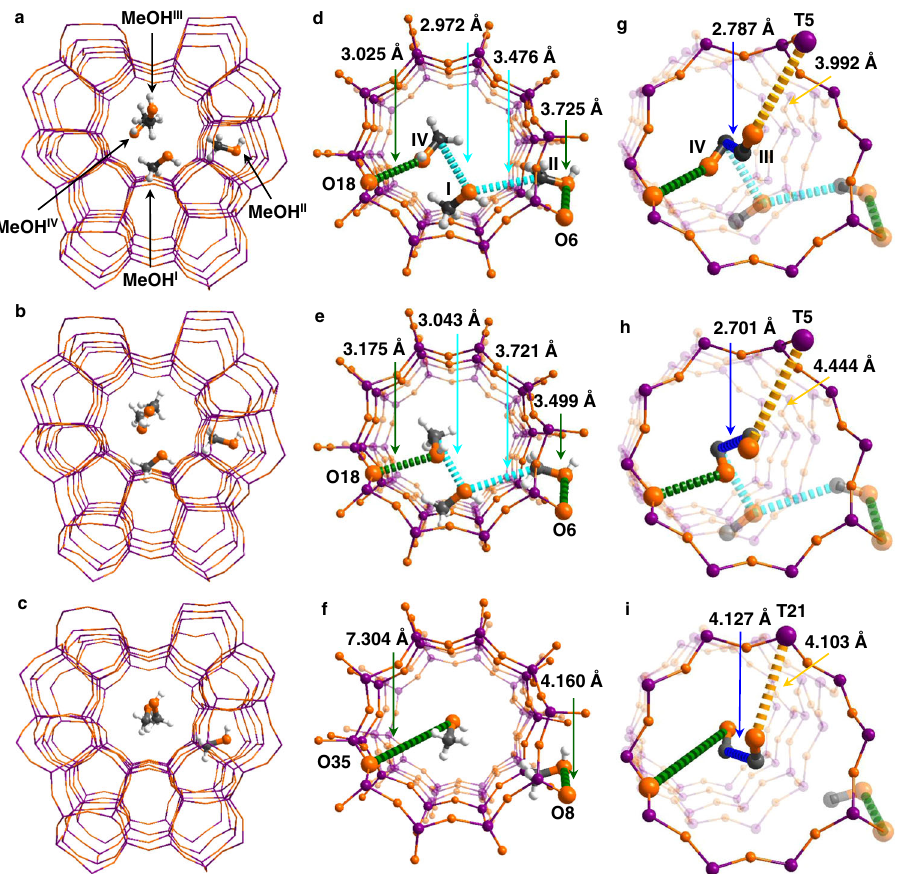
Fig. 3 Views of crystal structures of MeOH-loaded TaAlS-1(0.013/0.027/1), HZSM-5(0.027/1) and TaS-1(0.013/1). All models were obtained from Rietveld re fi nements of SXPD data. Four distinct binding sites (I – IV) for MeOH have been observed in the straight and sinusoidal channels. a TaAlS-1 (0.013/0.027/1) · 8.6MeOH (Al 2.5 Ta 1.2 Si 92.3 O 192 · 8.6CH 4 O), b HZSM-5(0.027/1) · 12.3MeOH (Al 2.5 Si 93.5 O 192 · 12.3CH 4 O). c TaS-1(0.013/1) · 4.0MeOH (Ta 1.2 Si 94.8 O 192 · 4.0CH 4 O). Only three binding sites were observed in TaS-1. The details of the host – guest binding are enlarged in d – i . Detailed views of